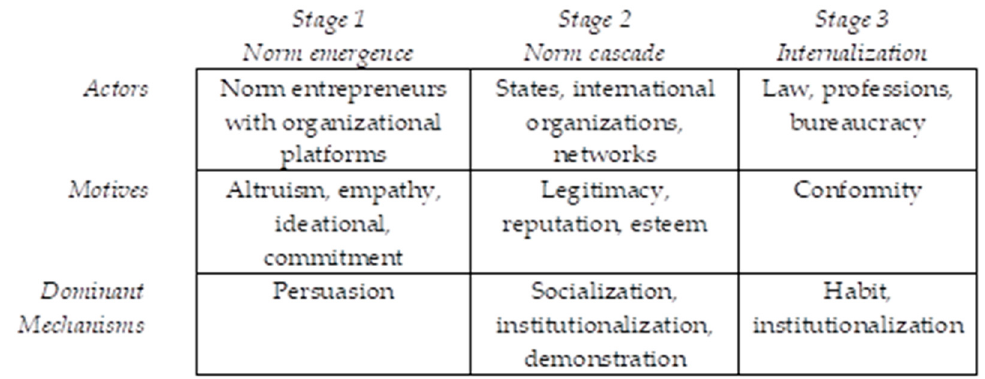
Figure 1. The Norm Life Cycle (Finnemore and Sikkink 1998).